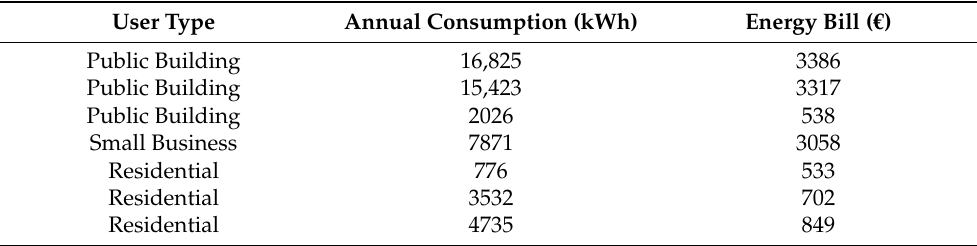
Table 1. Users of the Magliano Alpi REC—annual consumption and energy bill details.